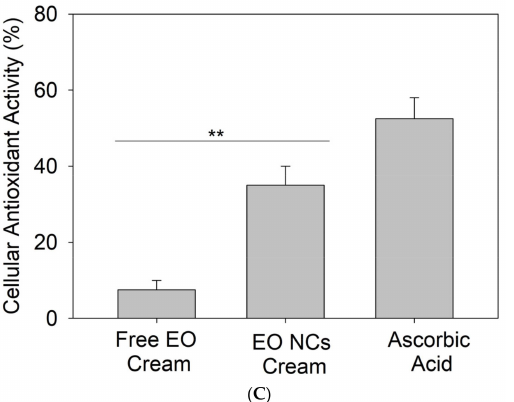
Figure 4. ( A ) Antioxidant activity of bulk EO and EO-loaded NCs, ( B ) free DPPH radical scavenging by the free EO and EO-loaded NC creams, and ( C ) cellular antioxidant activity of the free EO and EO-loaded NC creams. All experiments were performed in triplicate, and the data are expressed as the mean ± standard deviation. ** stands for p < 0.05, considered statistically